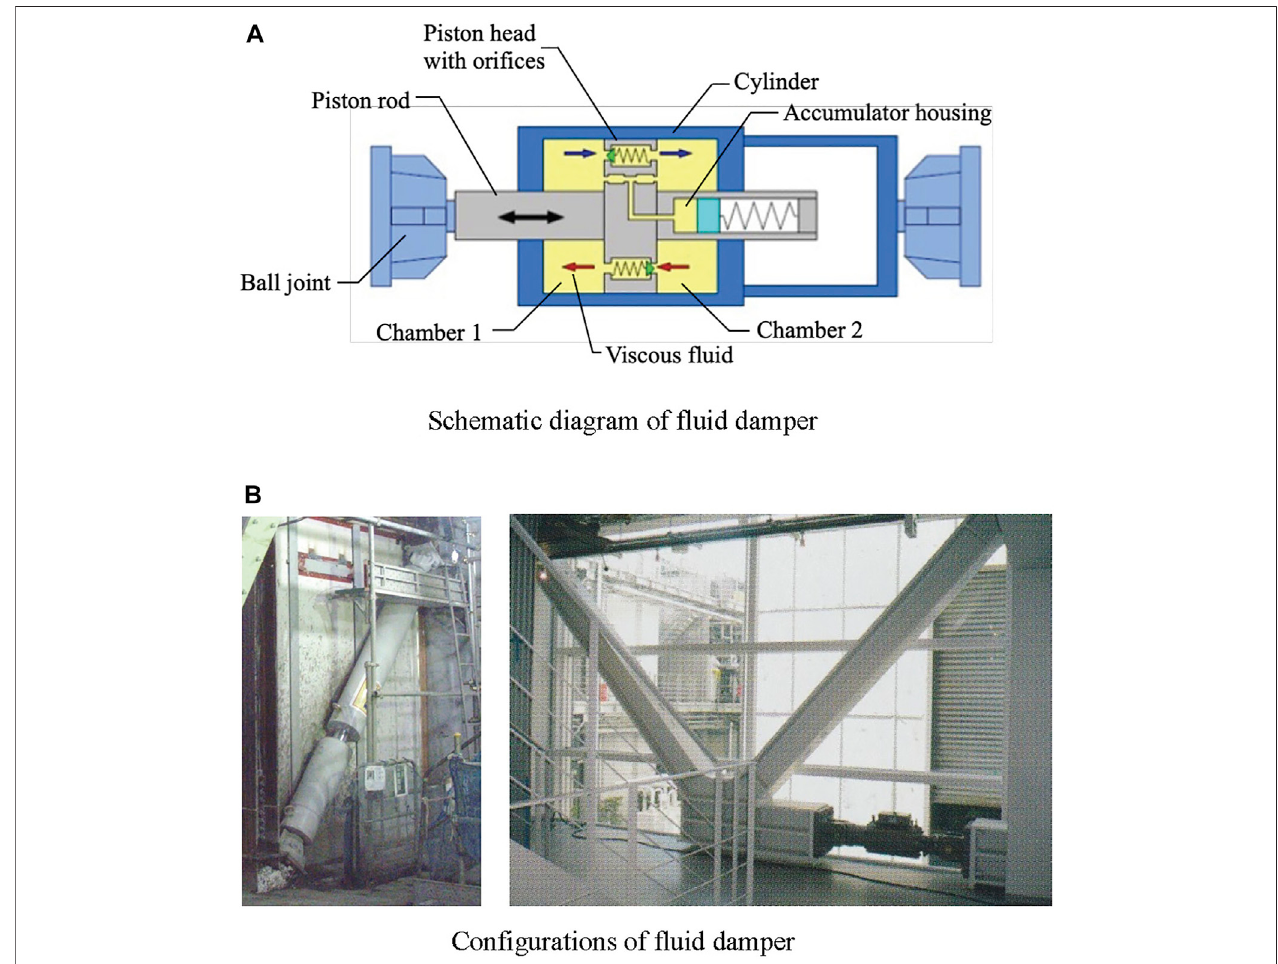
FIGURE 1 | Fluid damper for buildings. (A) Schematic diagram of fl uid damper. (B) Con fi gurations of fl uid damper